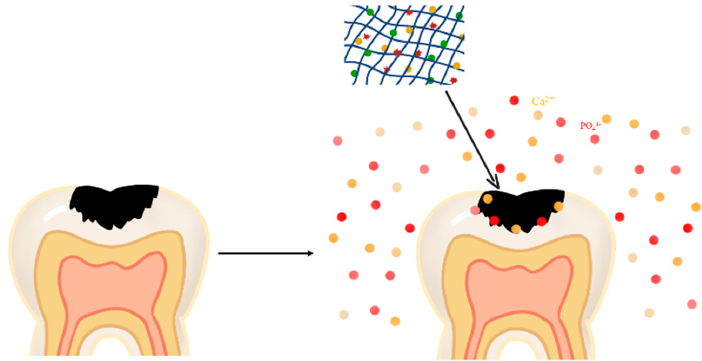
Figure 4. Application of hydrogel in hard tissue regeneration of teeth.